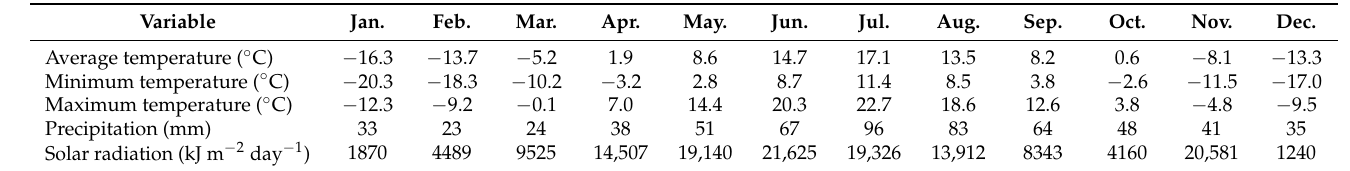
Table 1. Climatic data for the studied mountain stony shrub-moss-lichen tundra of the Northern Urals (WorldClim version 2.1 climate data for 1970–2000